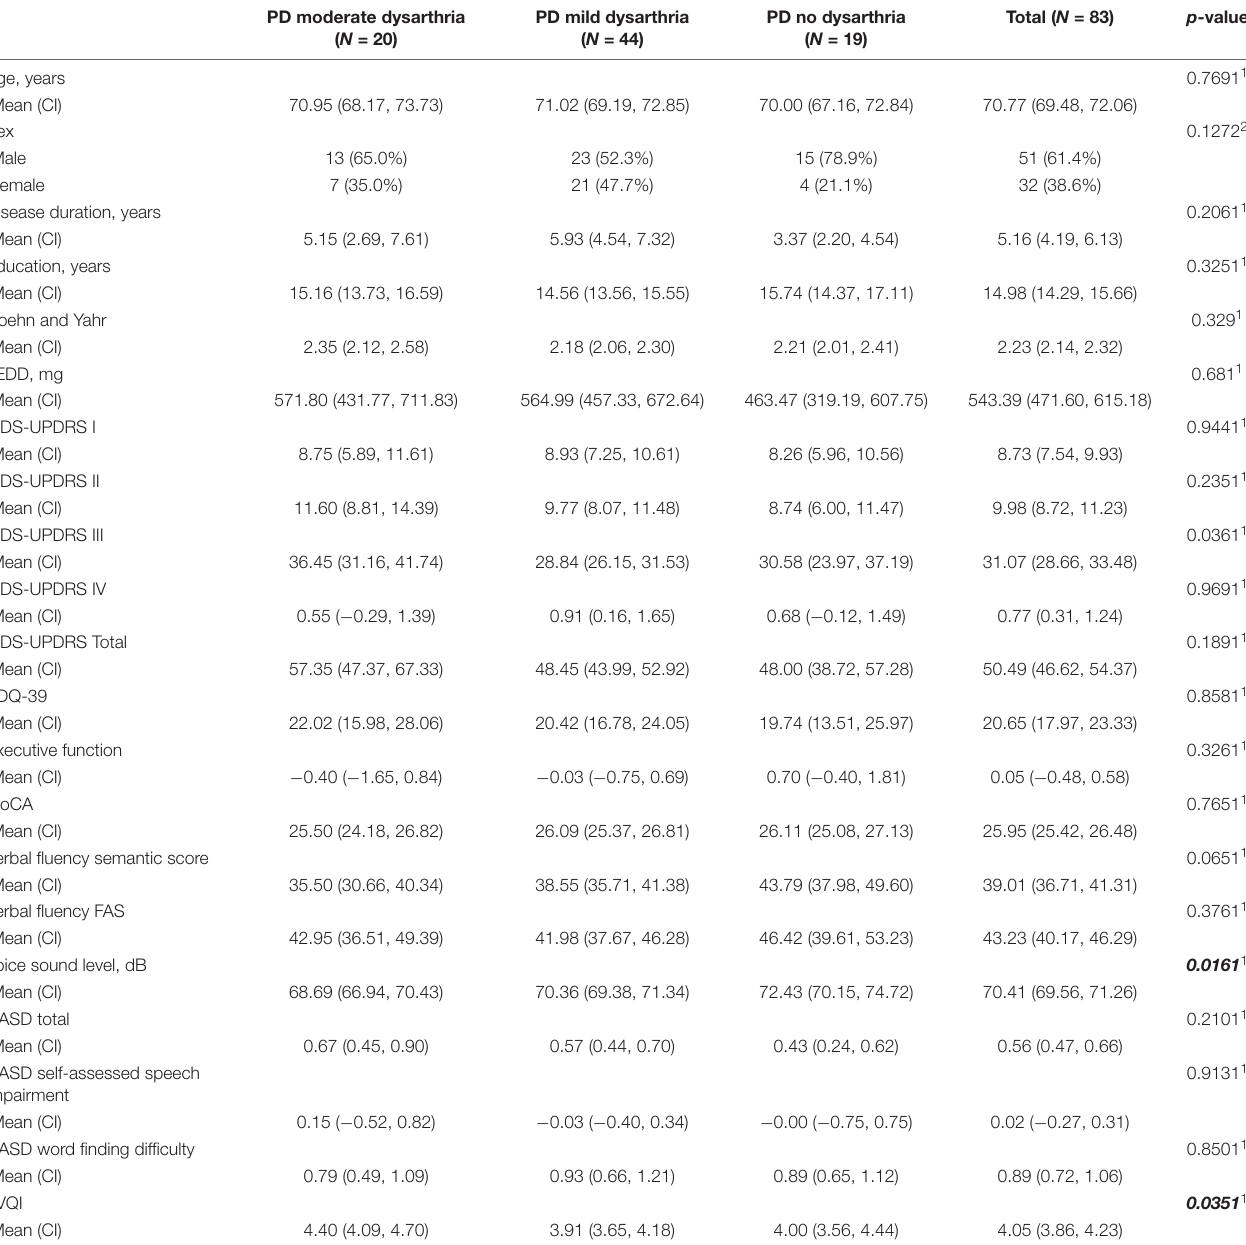
TABLE 1 | Demographic, motor, cognitive, and clinical data for participants with PD stratified into dysarthria severity levels and PD without